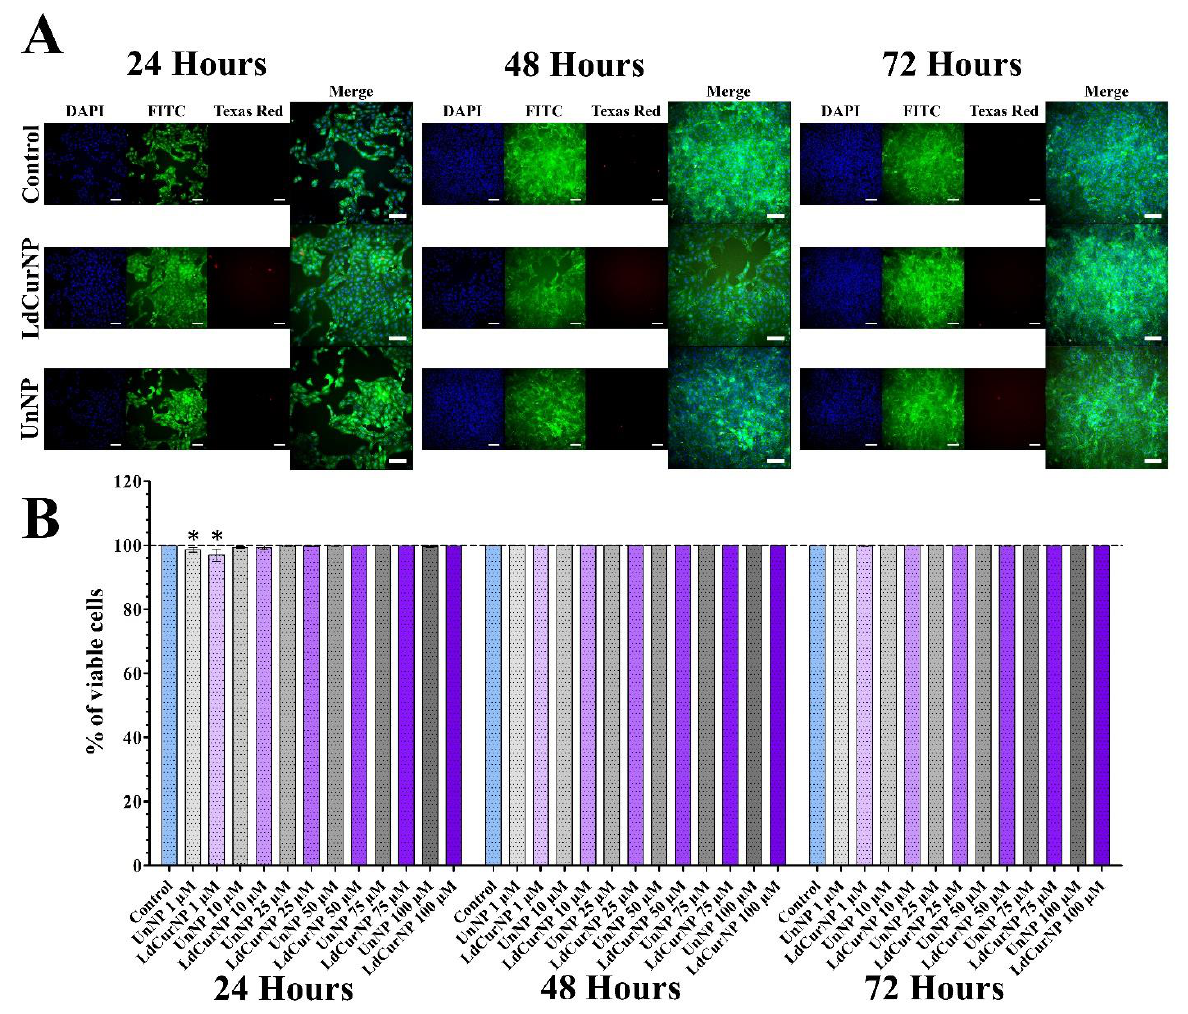
Figure 7. LIVE/DEAD viability assays of differentiated Vero cells after 24, 48 and 72 h of incubation with the nanoparticles’ suspensions in different concentrations. ( A ) Representative images of control, L-DOPA and Curcumin-loaded nanoparticles (LdCurNP) 100 µM and unloaded nanoparticles (UnNP) 100 µM. Cells nuclei were stained with Hoechst 33342 and observed with the DAPI channel, live cells were stained with calcein and observed in the FITC channel, dead cells were stained with ethidium homodimer-1 and observed in the Texas Red channel. (Scale bar 100 µm). ( B ) LdCurNP and UnNP suspensions in concentration of 1, 10, 25, 50, 75 and 100 µM, Values were presented as mean ± standard error of the % of viable cells (* p < 0.05; n.s. p > 0.05).